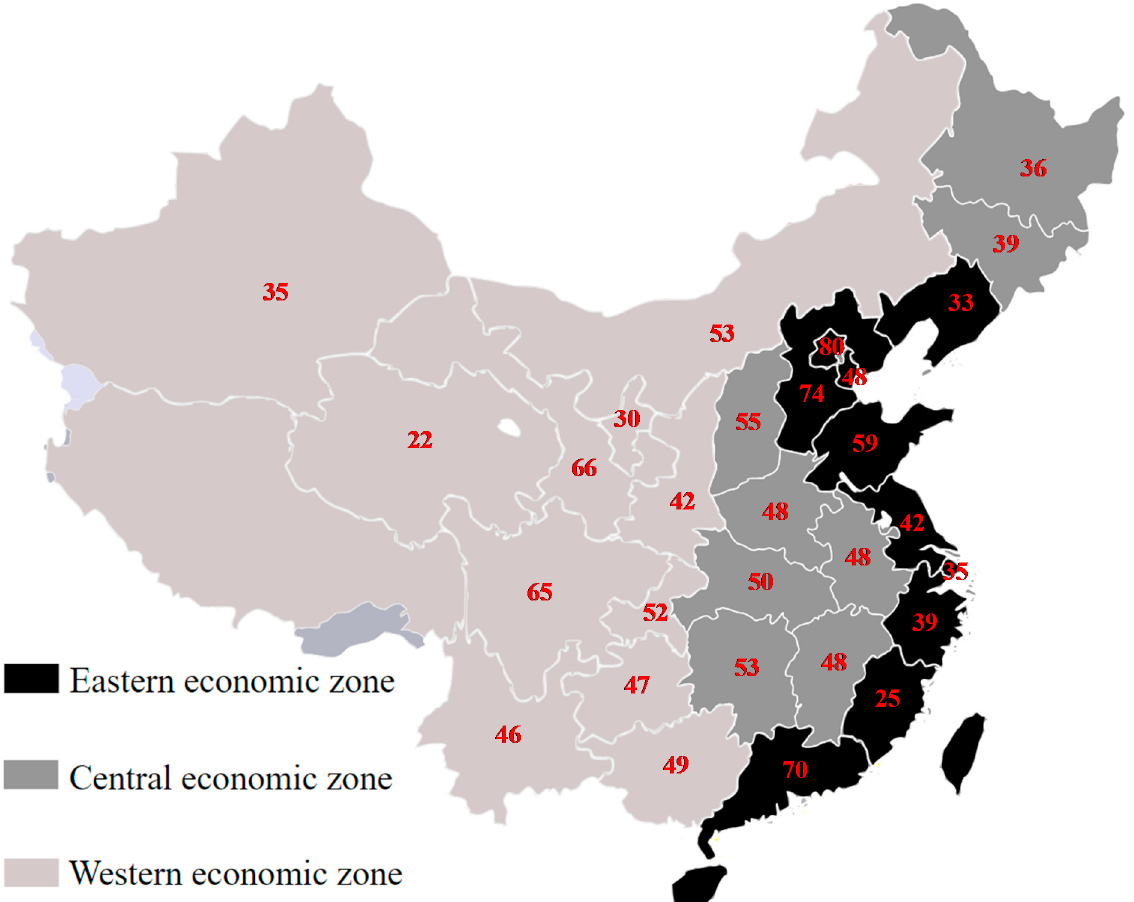
Figure 1. Three economic zones in mainland China (30 provinces). The number with red font indicates the number of participating hospitals in 2018 in the China Antimicrobial Resistance Surveillance System (CARSS) in each province and autonomous region. We excluded the Tibet autonomous region due to missing data.